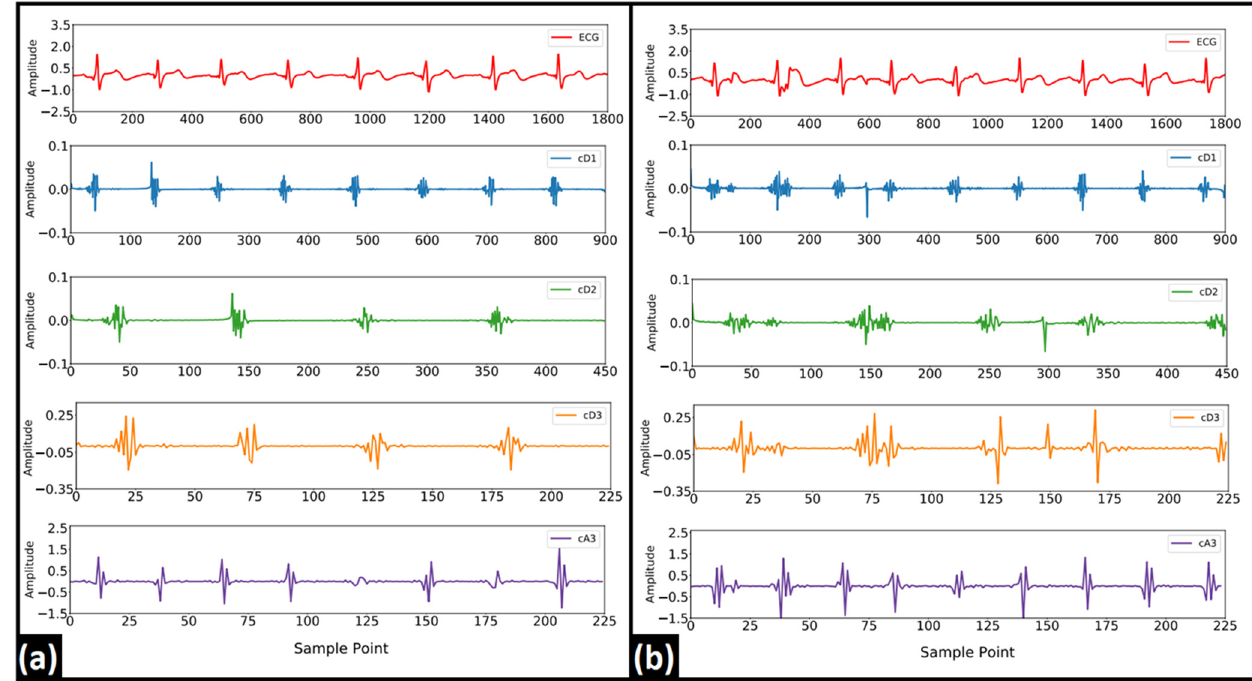
Figure 5. Typical IMFs of a 5 s ECG signal ( a ) before and ( b ) after consumption of coffee. Figure 7. Typical DWT coefficients after level-3 decomposition using db6 mother wavelet ( a ) before and ( b ) after the consumption of coffee.